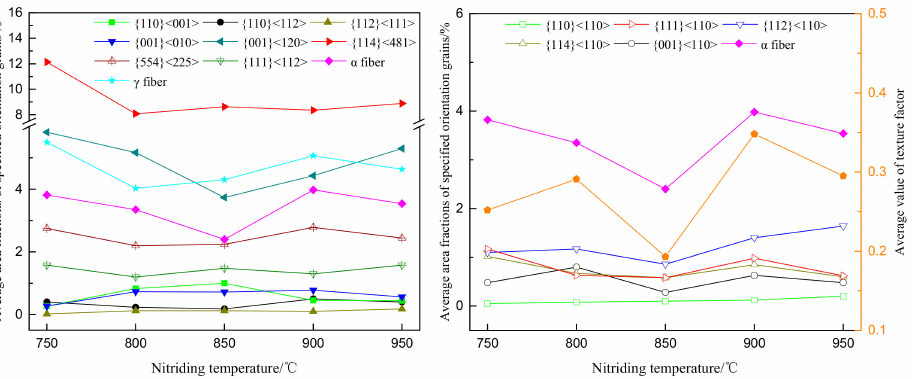
Figure 4. Relation between the nitriding temperature and average area fractions of specified orientation grains and the average value of texture factor in a nitrided